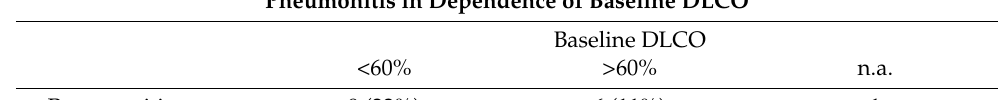
Table 4. Clinically relevant pneumonitis in dependence of baseline DL CO . If baseline DL CO was <60%, the probability of clinically relevant pneumonitis was approximately twice as high as in patients with DL CO above this threshold (n.a. = not assessable).